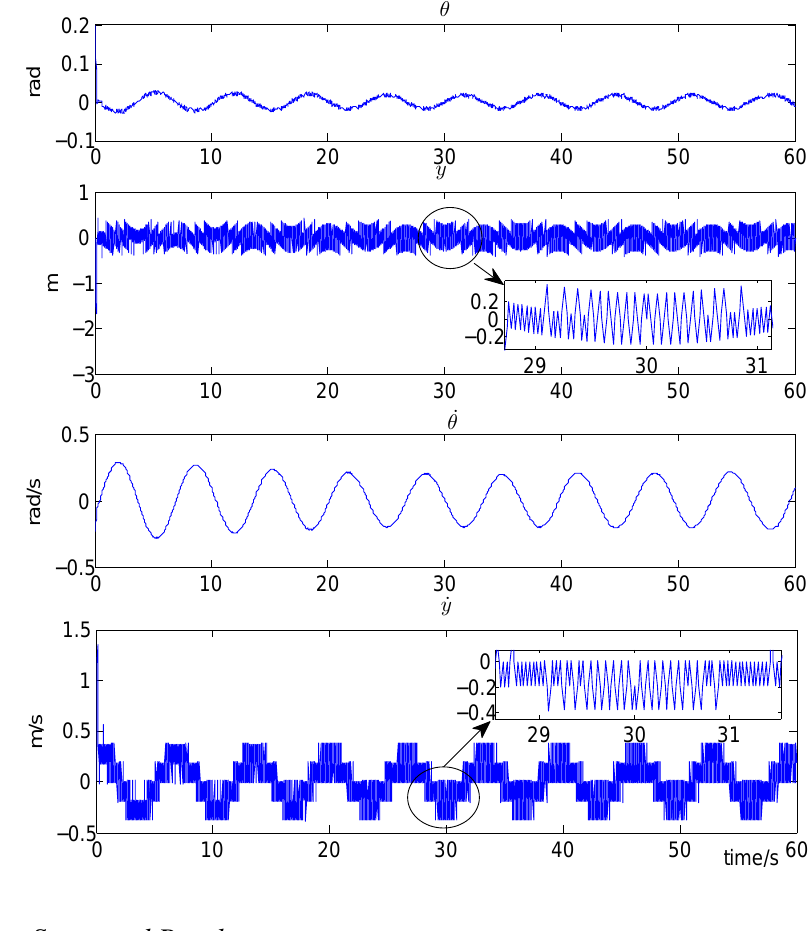
Figure 2. State profiles of the cart-pole system with the proposed control